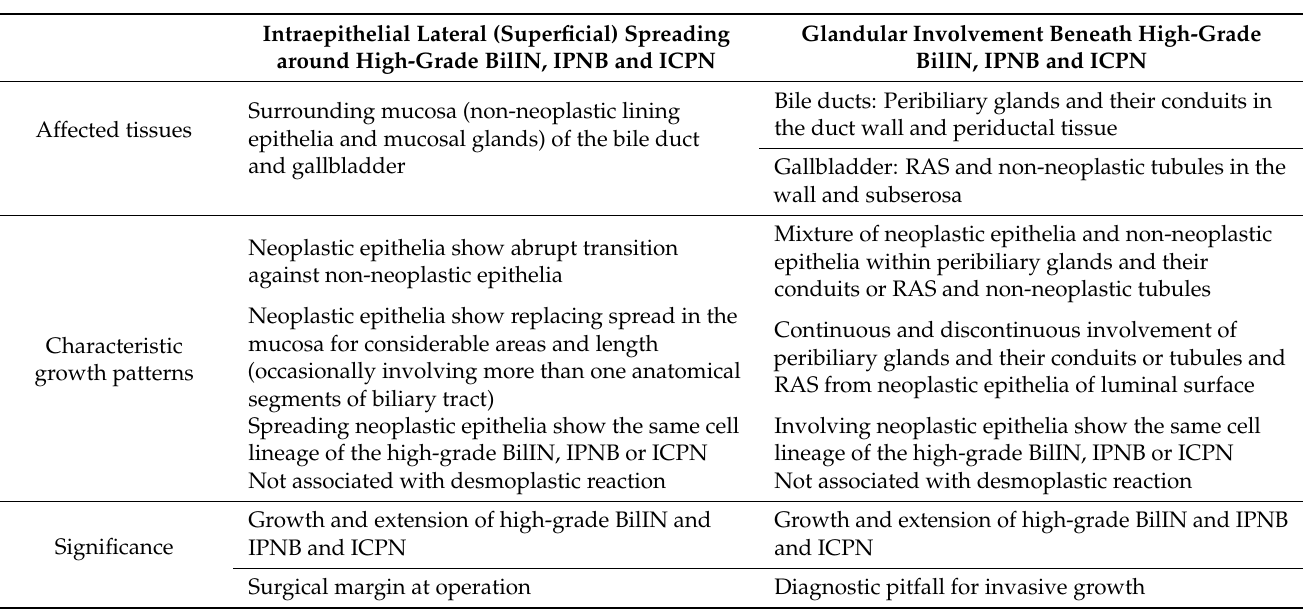
Table 4. Intraepithelial lateral spreading and glandular involvement by neoplastic epithelia in the bile duct and gallbladder in high-grade BilIN (biliary intraepithelial neoplasm), IPNB (intraductal papillary neoplasm of bile duct) and ICPN (intracholecystic papillary neoplasm). Intraepithelial Lateral (Superficial) Spreading Glandular Involvement Beneath